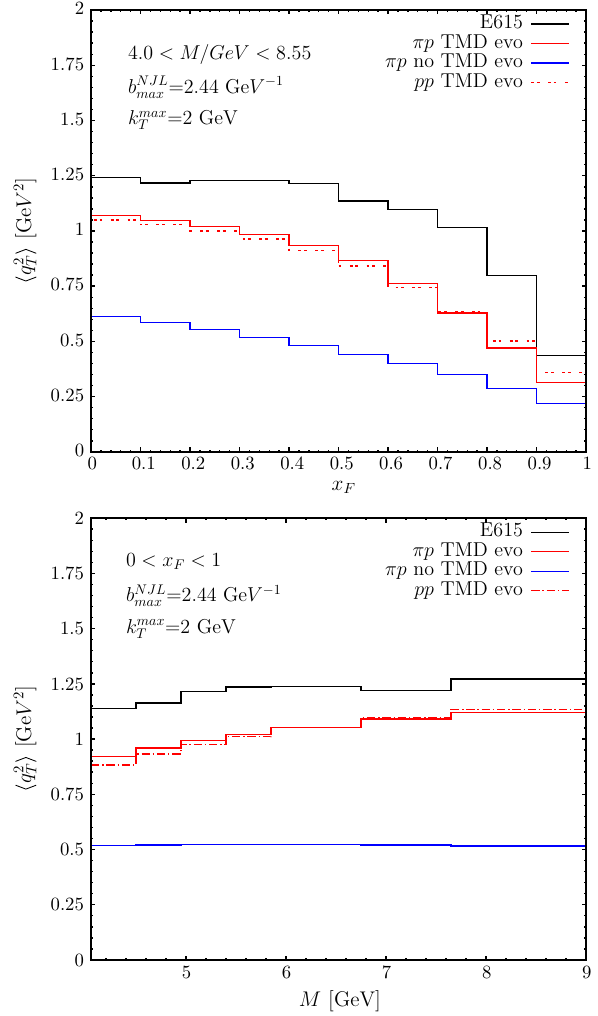
(cid:15) , as T = 2 T